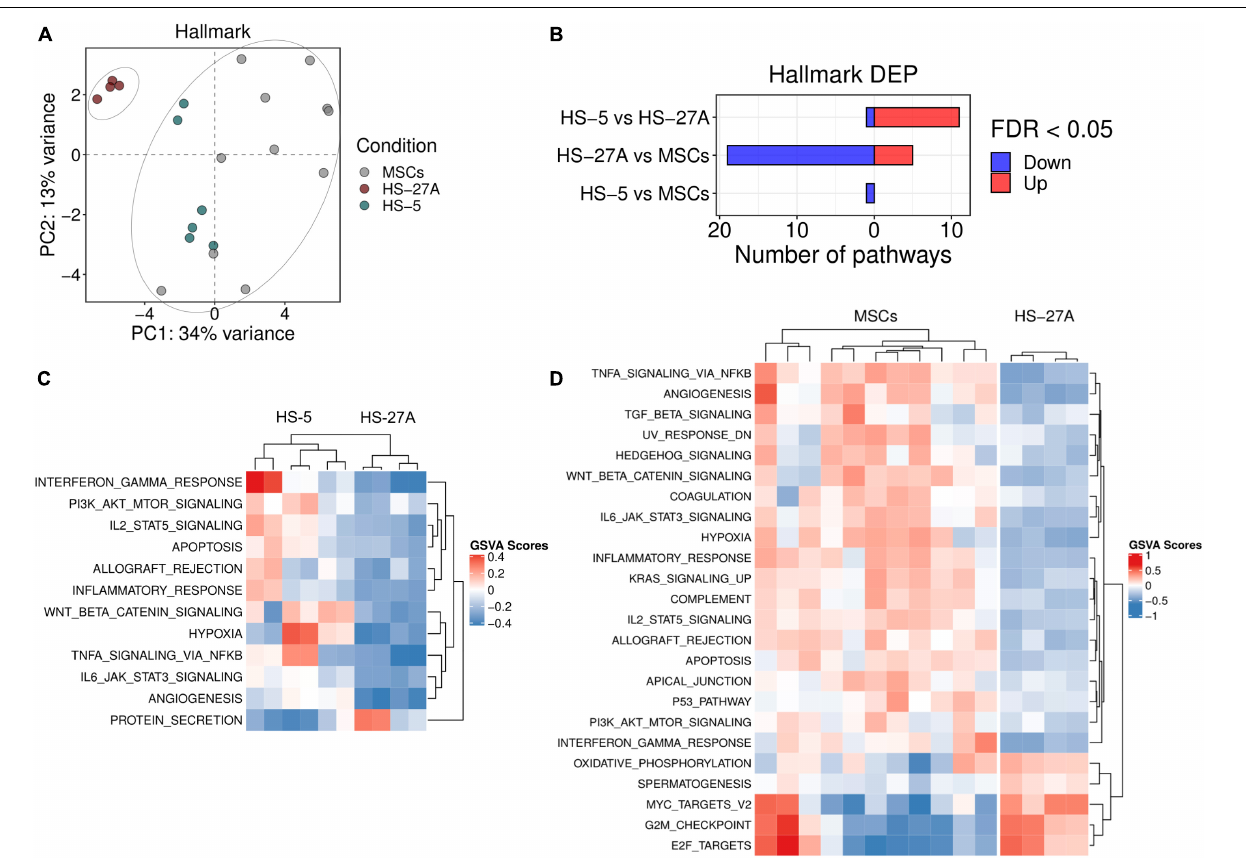
FIGURE 3 | Tumor-affecting pathways expression on primary MSCs, HS-5 and HS-27A cell lines. (A) Score plot of the first two PCs following the application of PCA on DEP included in Hallmark gene sets collection between primary MSCs, HS-5, and HS-27 cell lines. (B) Number of significantly down- and up-regulated pathways included in Hallmark gene sets collection between primary MSCs, HS-5, and HS-27 cell lines. (C) Heatmap summarizing significantly DEP between HS-5 and HS-27 cell lines. (D) Heatmap summarizing significantly DEP between primary MSCs and HS-27 cell lines. ( n MSCs, HS-5, HS-27A = 11, 6, 4). PCs, principal components; PCA, principal component analysis; DEP, differentially expressed